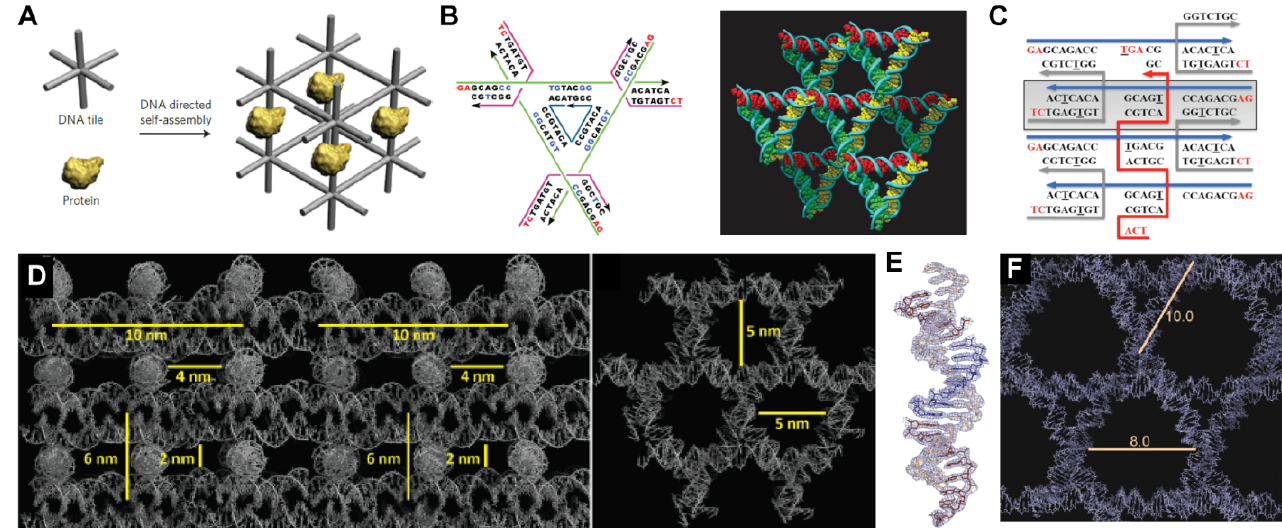
Figure 2. Self-assembled DNA crystal lattices. ( A ) Original concept of DNA nanotechnology as conceived by Seeman: using a self-assembled DNA lattice to scaffold proteins in well-defined orientations in 3D space [7].Reprinted with permission from ref. [8], Copyright 2011 Springer Nature. ( B ) Design (left) and 3D crystal structure (right) of Seeman and Mao’s original tensegrity triangle crystal design. Reprinted with permission from ref. [9], Copyright 2009 Springer Nature. ( C ) Crystal design with a weaving strand (red) linking four duplexes via Holliday junctions. Reprinted with permission from ref. [11], Copyright 2016 American Chemical Society. ( D ) Two views of the 3D crystal structure using the weaving strand with stacked duplexes design. Reprinted with permission from ref. [11], Copyright 2017 American Chemical Society. ( E ) The asymmetric unit of a crystal design with 2.7 Å resolution, showing individual base stacks. Reprinted with permission from ref. [12], Copyright 2020 John Wiley and Sons. ( F ) This design enabled expanded cavities in the crystal, with void spaces approaching 10 nm in diameter.